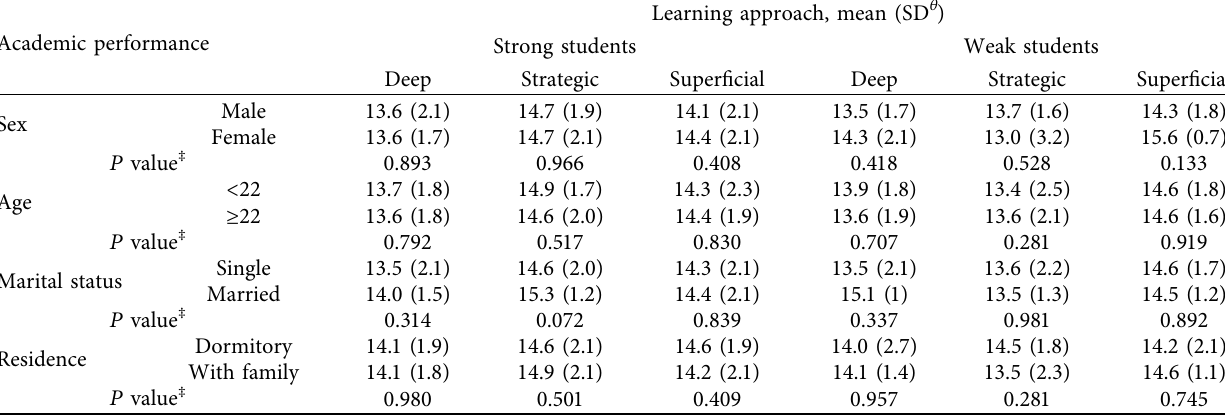
θ Standard deviation. ‡ Based on the independent t -test. † Based on analysis of